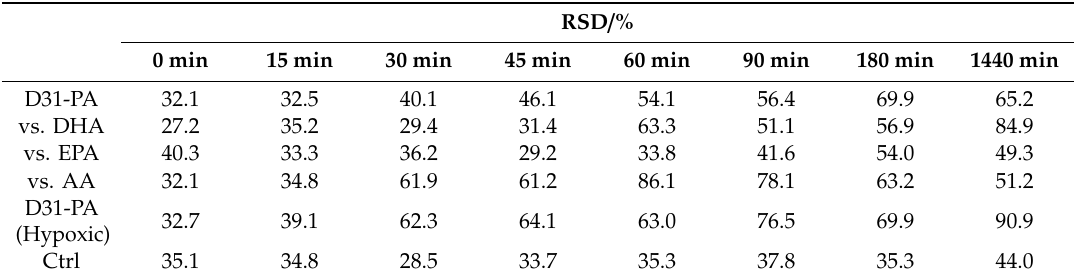
Table A1. RSD calculated in the D31-PA uptake (2106 cm 1 peak only).